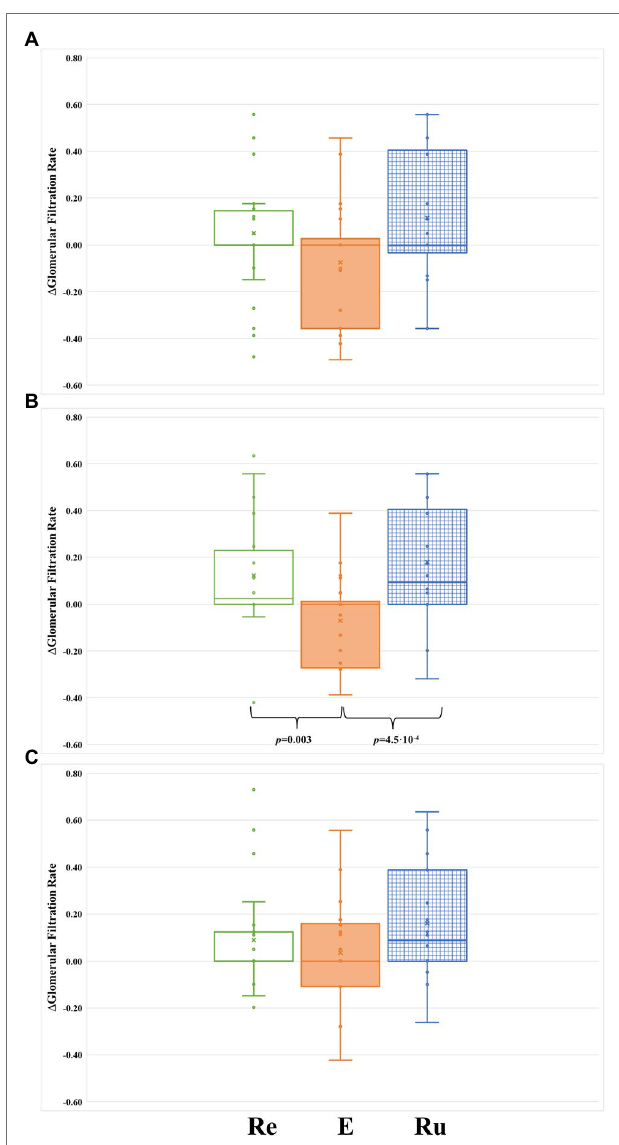
FIGURE 2 | Comparison of ∆ GFR between the tree groups during the intervention phase of the study. (A) After 48 h from the first intervention (at 96 h post-marathon). (B) After 48 h from the second intervention (at 144 h post-marathon). (C) After 48 h from the third intervention (at 192 h post- marathon). Re, participants included in the REST group (green-rimmed boxes); E, participants included in the ELLIPTICAL group (orange-filled boxes); and Ru, participants included in the RUN group (blue-dashed